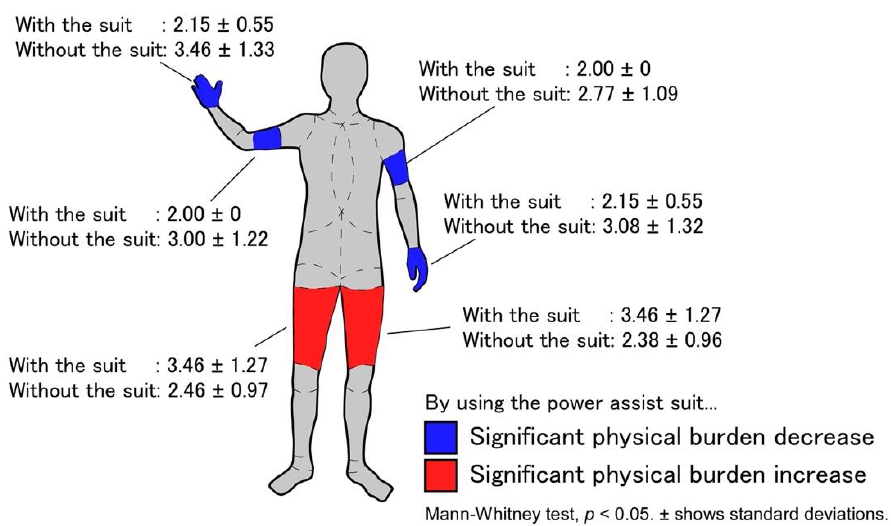
Figure 9. Change in physical burden on body parts after using the power assist suit .